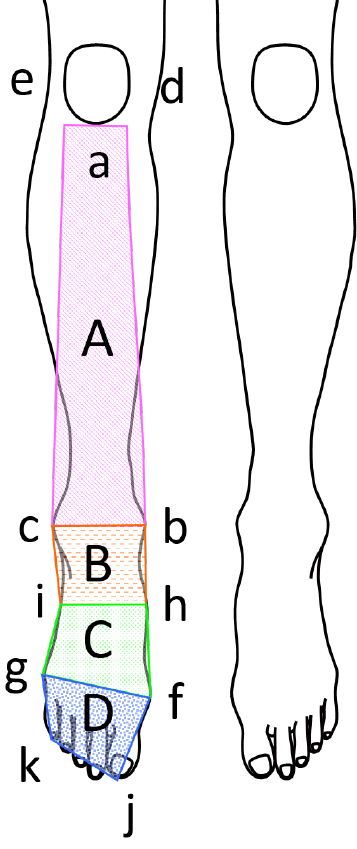
Figure 1. Arbitrary frames used to analyze skin temperature of lower limb ( a ). A. Anterior aspect of lower leg frame (referred as Lower Leg in the text). B. Anterior aspect of ankle frame (referred as Ankle in the text). C. Dorsal proximal aspect of foot frame (referred as Proximal Foot in the text). D. Dorsal distal aspect of foot frame (referred as Distal Foot in the text). Anatomical land marks used to create arbitrary frames ( b ). a. Inferior border of the patella. b. Highest point of the medial malleolus. c. Highest point of the lateral malleolus. d. Medial border of the patella. e. Lateral border of the patella. f. Medial aspect of the 1st metatarsophalangeal joint. g. Lateral aspect of the 5th metatarsophalangeal joint. h. Midpoint between b and f. i. Midpoint between c and g. j. Distal end of the 1st phalanx. k. Distal end of the 5th phalanx.